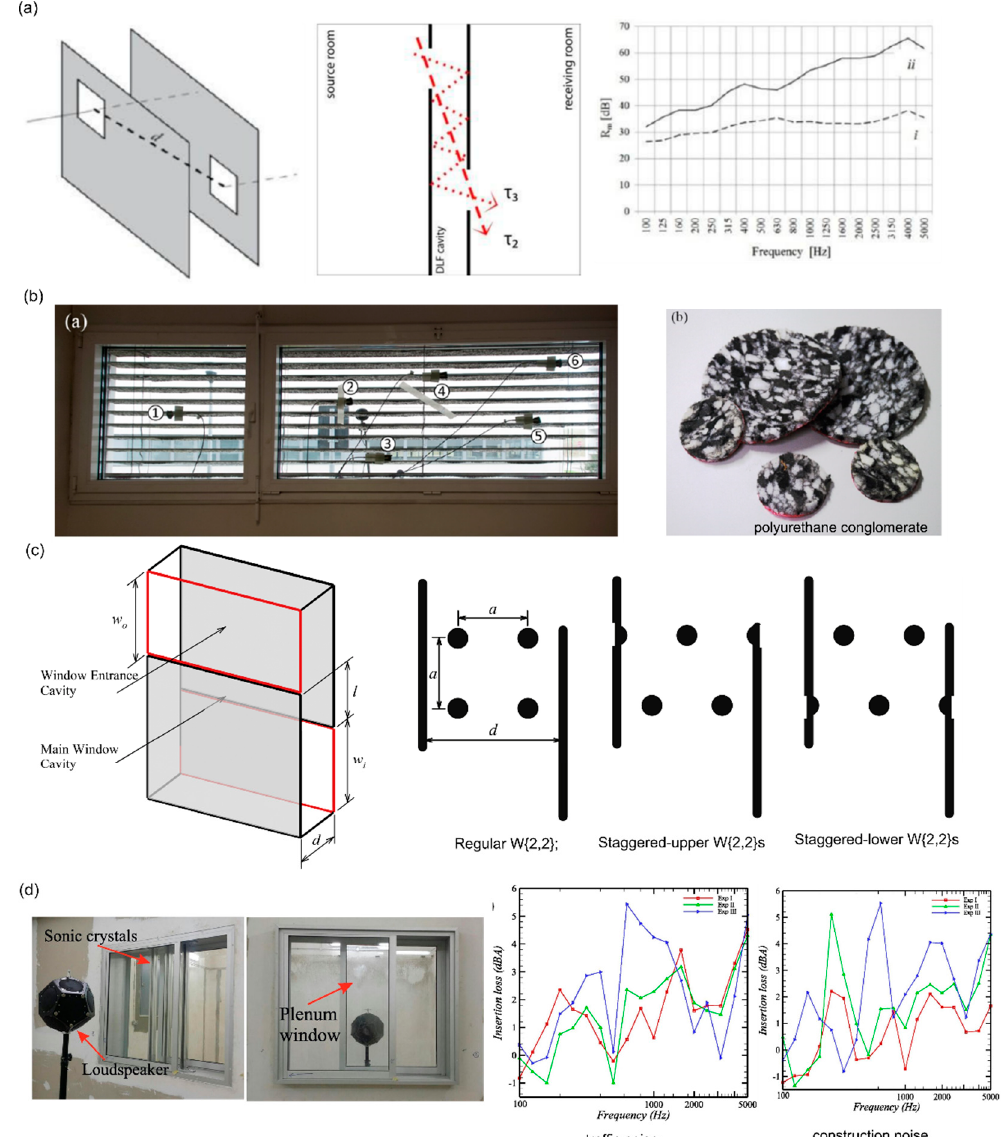
Figure 3. ( a ) Schematic illustrations of the double-layered façade system with openings and the measured sound reduction index (Rm) of the experimental wall (i): one layer fully closed and one fully open; (ii): both layers fully closed). Reprinted with permission from Bajraktari et al. [83] , © 2020